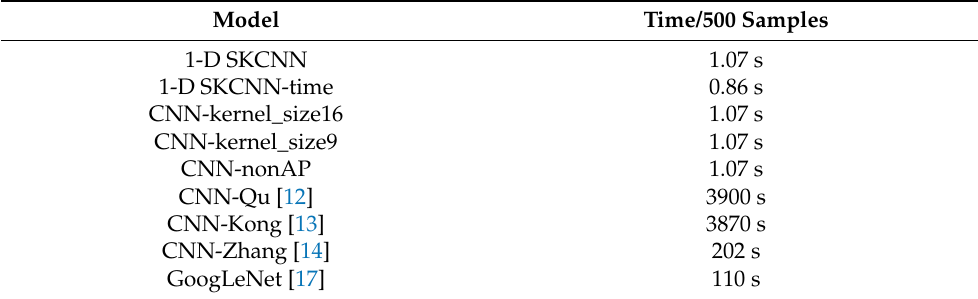
Table 4. The time usage of the methods to preprocess 500 randomly selected samples.